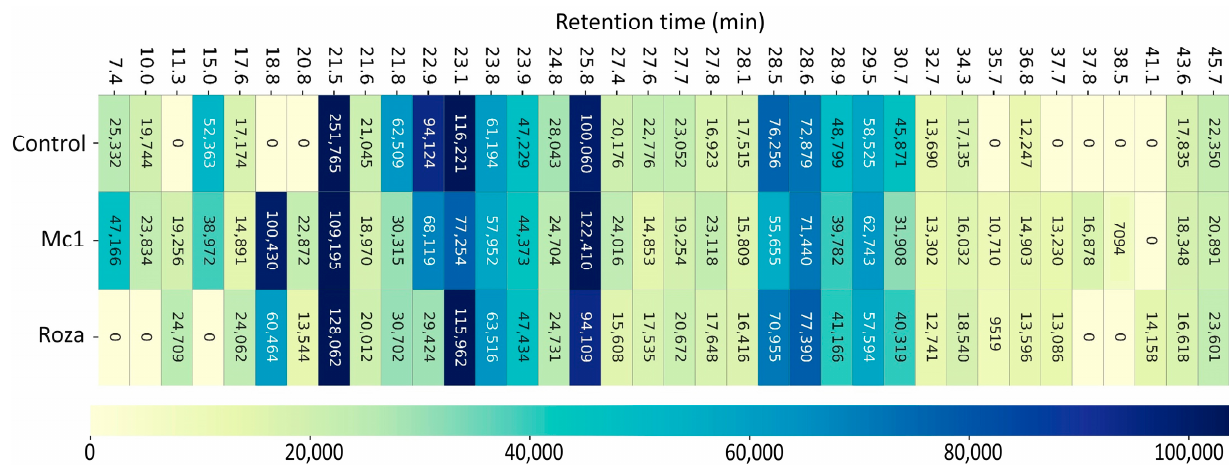
Figure 4. Heat-map showing the peak intensity extracted from GC-FID data of samples from potato SB22 plants infected with M. chitwoodi Race 1 (Mc1) and its pathotype Roza by combining all time points (2, 5, 10, and 25 DAI).